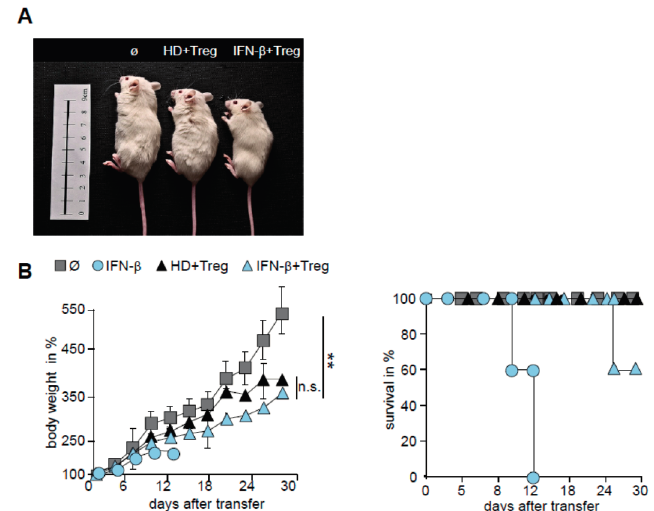
Figure 5. IFN- β therapy renders T cells responsiveness against suppressive function of Treg in vivo . ( A ) Shown are mice 20 days after transfer of PBMC from HD or IFN- β -treated MS patients with injection of gp120 compared with untreated mice; ( B ) Treg were depleted within PBMC of HD (black) or IFN- β -treated MS patients (blue) and replaced with the same amount of Treg from an independent HD. Subsequently, 5 × 10 6 cells were injected with or without gp120 (5 g/mouse) intraperitoneally into newborn NOD/ Scid γ c − / − mice. Untreated mice served as controls ( n = 5). Each point represents the cumulative mean weight of one group (five mice per group), p -values relative to mean body weight of mice administered with PBMC from IFN- β -treated MS patients with Treg * p < 0.05, ** p < 0.01 are shown. n.s. means no significance. (Right) survival of mice in Kaplan–Meier plot within 30 days is shown. One of four independent experiments is